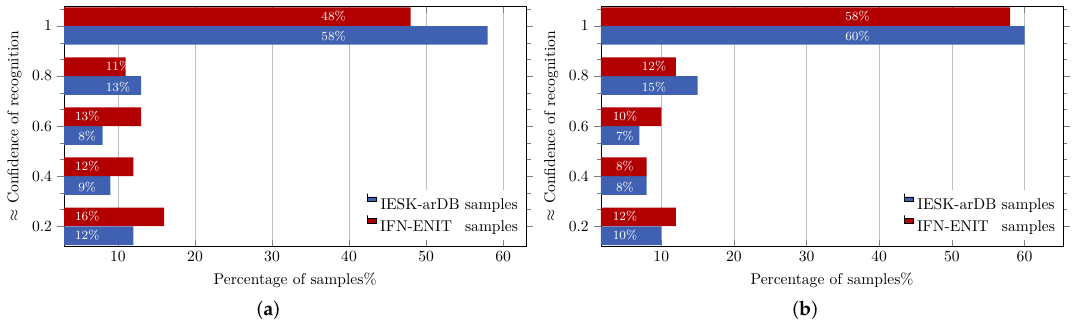
Figure 10. CRF and HCRF word-based performance on evaluation sets of the IESK-arDB and IFN-ENIT databases: ( a ) CRF performance; ( b ) HCRF